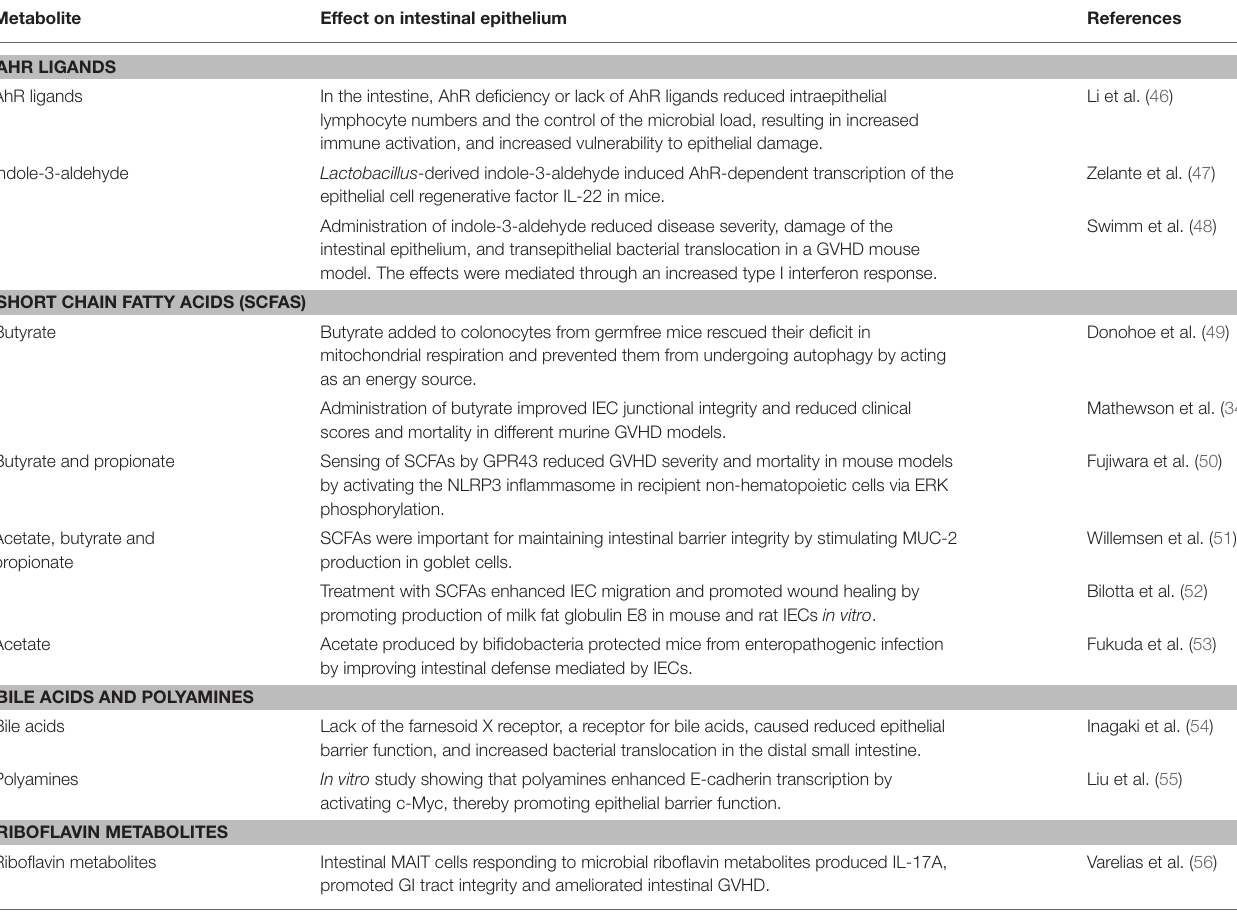
TABLE 2 | Summary of studies investigating how microbial metabolites affect intestinal epithelial